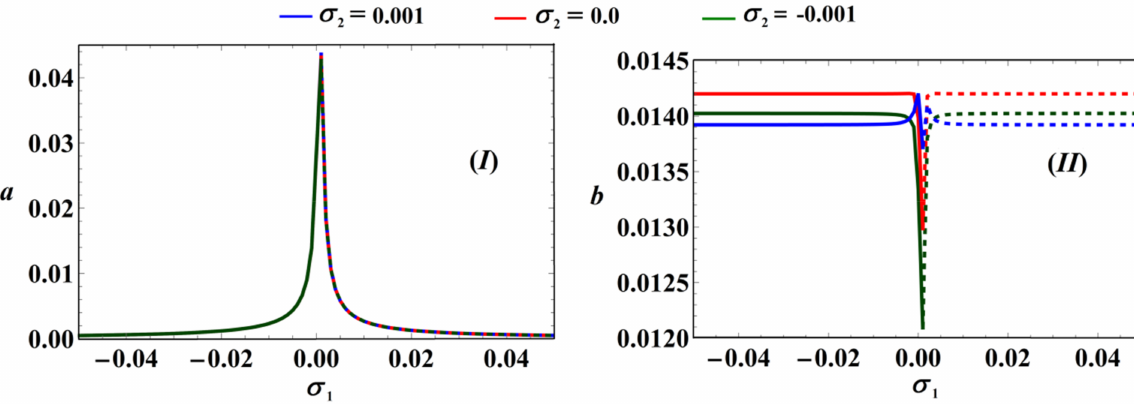
Figure 23. The resonance curves of: ( I ) a ( σ 1 ) and ( II ) b ( σ 1 ) when W = 0.448, c 1 = 0.001, and c 2 =